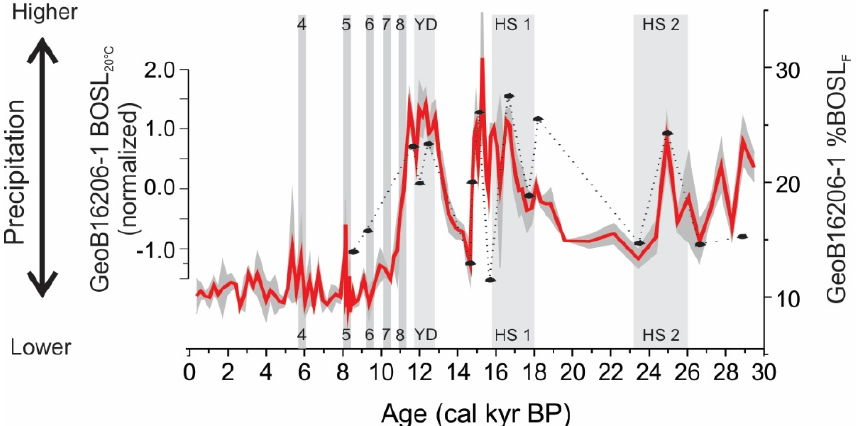
Figure 4. Comparison between BOSL F sensitivity and sensitivity measured at room temperature (BOSL 20°C ). ( A ) BOSL 20°C sensitivity measured without pause between dose and blue stimulation. ( B ) BOSL 20°C sensitivity measured with 16 h pause between dose and blue stimulation. Each sample is represented by the average of three aliquots. Error bars correspond to the standard deviation.